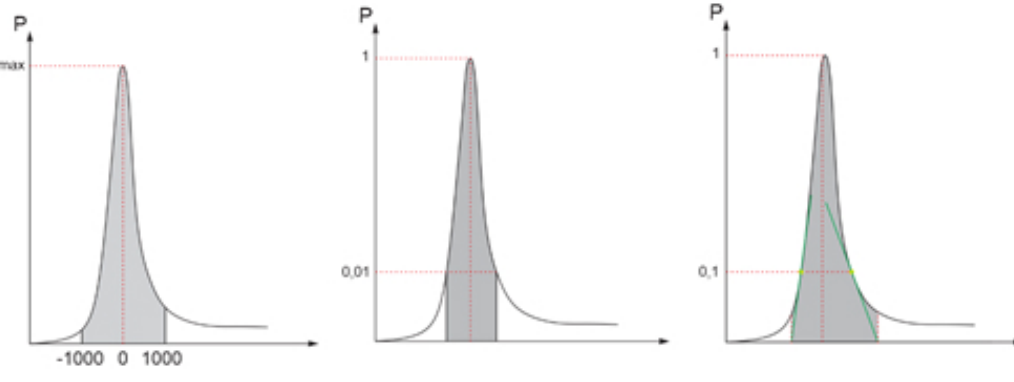
Figure 6: The determination of the total energy released using three methods: 1000pts (left), 1% (centre) and tangent